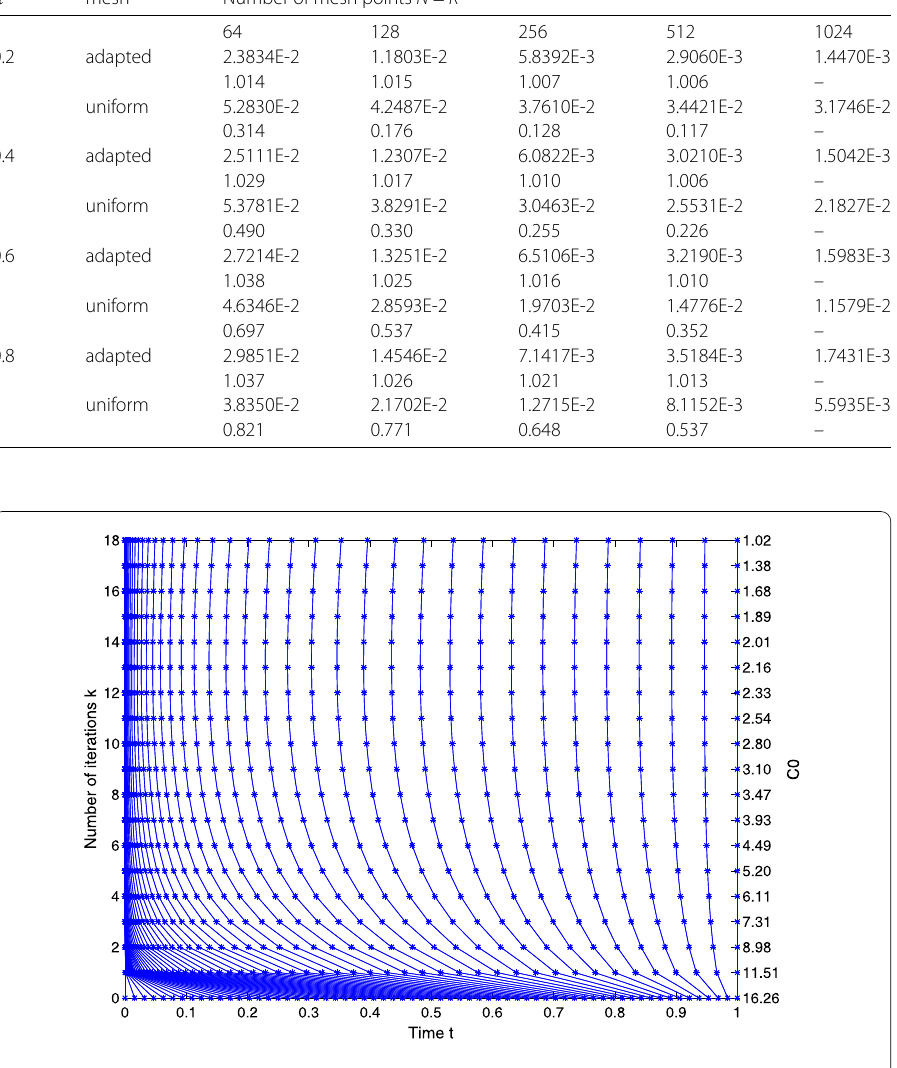
for Example 5.2 are listed in Table 2. The generation of adapted moving meshes after each iteration for the time discretization is depicted in Fig. 3. The final computed time mesh for the time-fractional Black–Scholes equation with α = 0.2 is depicted in Fig. 4, which also shows that the mesh points are concentrated near t = 0. The computed option value U is depicted in Fig. 5, which shows that the numerical solution by our method is non-